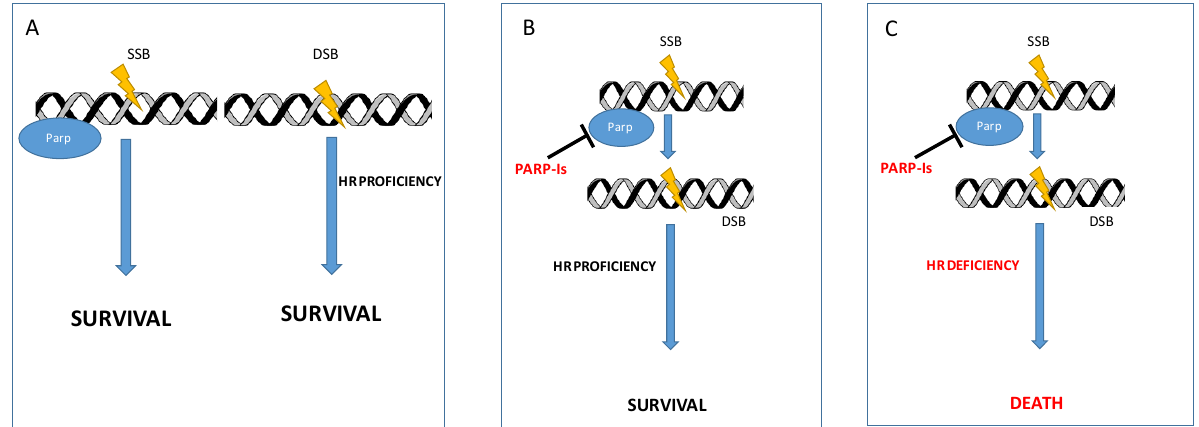
Figure 1. Synthetic lethality. (A) Normal cell with all the DNA repair mechanisms functioning; (B) PARP inhibition determines SSB accumulation that are effectively repaired in HR proficient cells; (C) PARP inhibition determines SSB accumulation that ultimately ends in multiple DSB cannot be repaired by HR deficient cells (synthetic lethality). DSB: double-strand break; SSB: